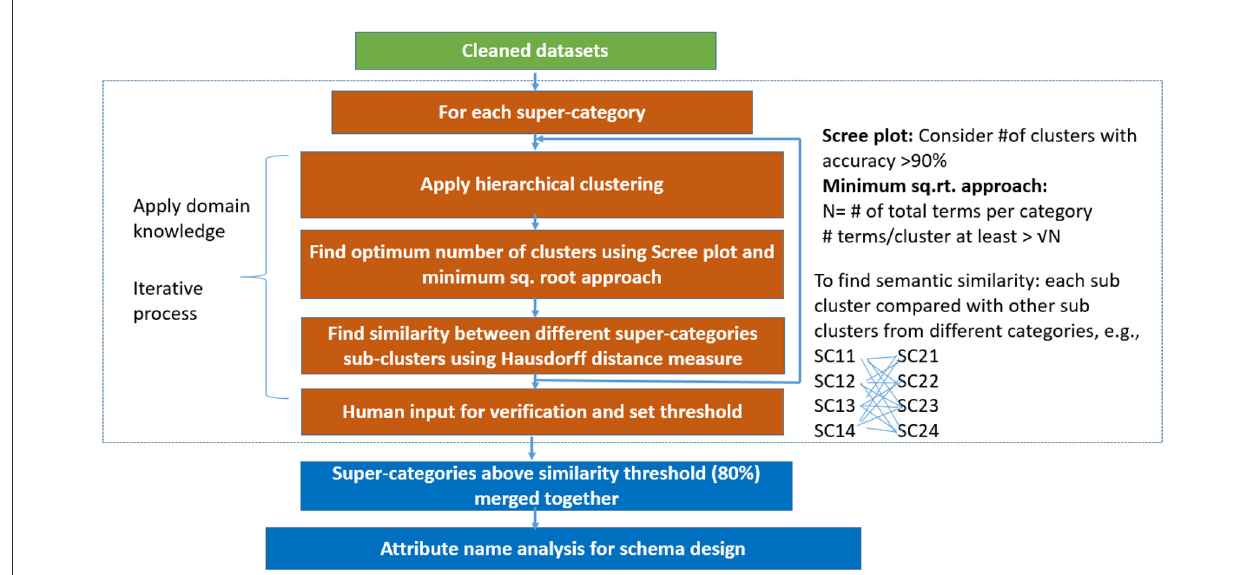
FIGURE2 Data categorization and integration system flow (SC, super-category